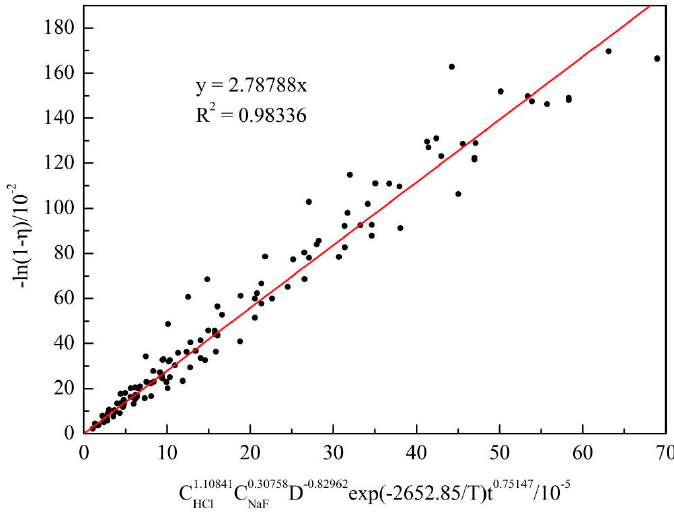
Figure 18. Plot of − ln(1 − η ) vs. C 1.10841